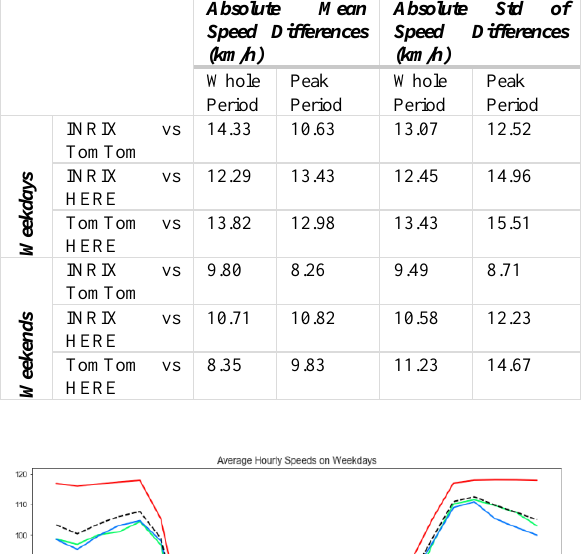
Table 3: A comparison of INRIX FCD performance compared to ground truth speeds on different segments. The segments